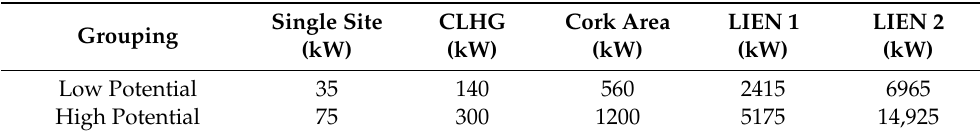
Table 8. Demonstration of the low and high potential capacities achievable by a single site and the four possible groupings within the Irish industrial sector to which this concept could be scaled